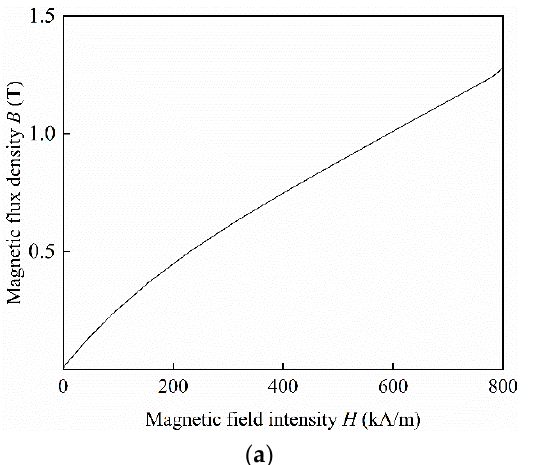
Figure 3. Magnetization curve of No. 10 steel.